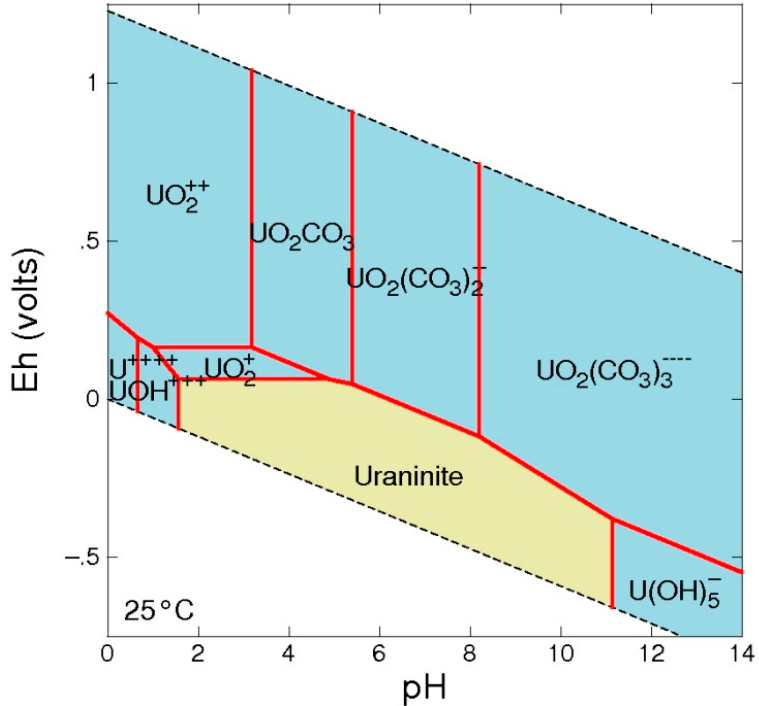
Figure 6. Eh-pH diagram of uranium. Diagram U ++++ , T = 25 °C, P = 1 bar, a [main] = 10 − 10 , a [H 2 O] = 1, a [HCO 3 − ] = 10 − 2 .